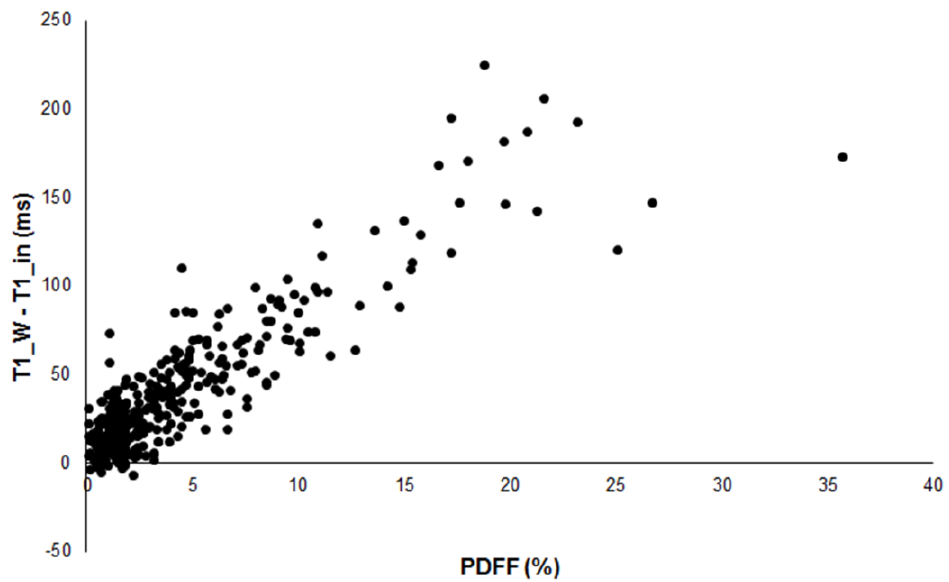
Figure 1. Scatterplot of the difference between T1_W and T1_in versus PDFF in 386 patients showing good correlation (R = 0.890).